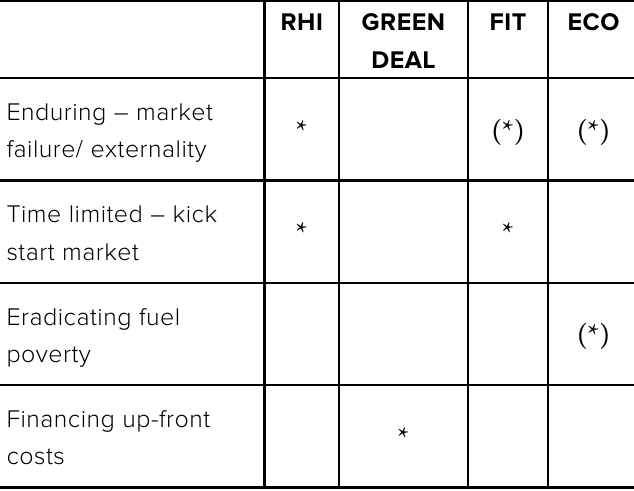
Table: Summary of objectives of current